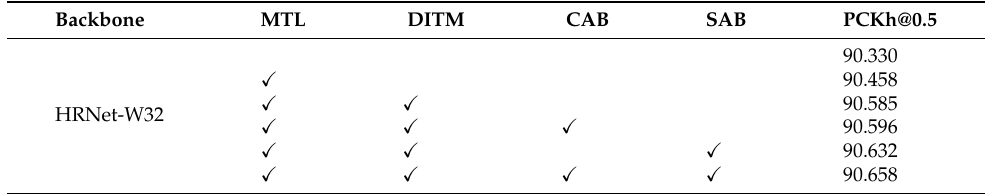
Table 5. Ablation study of each component in our framework.